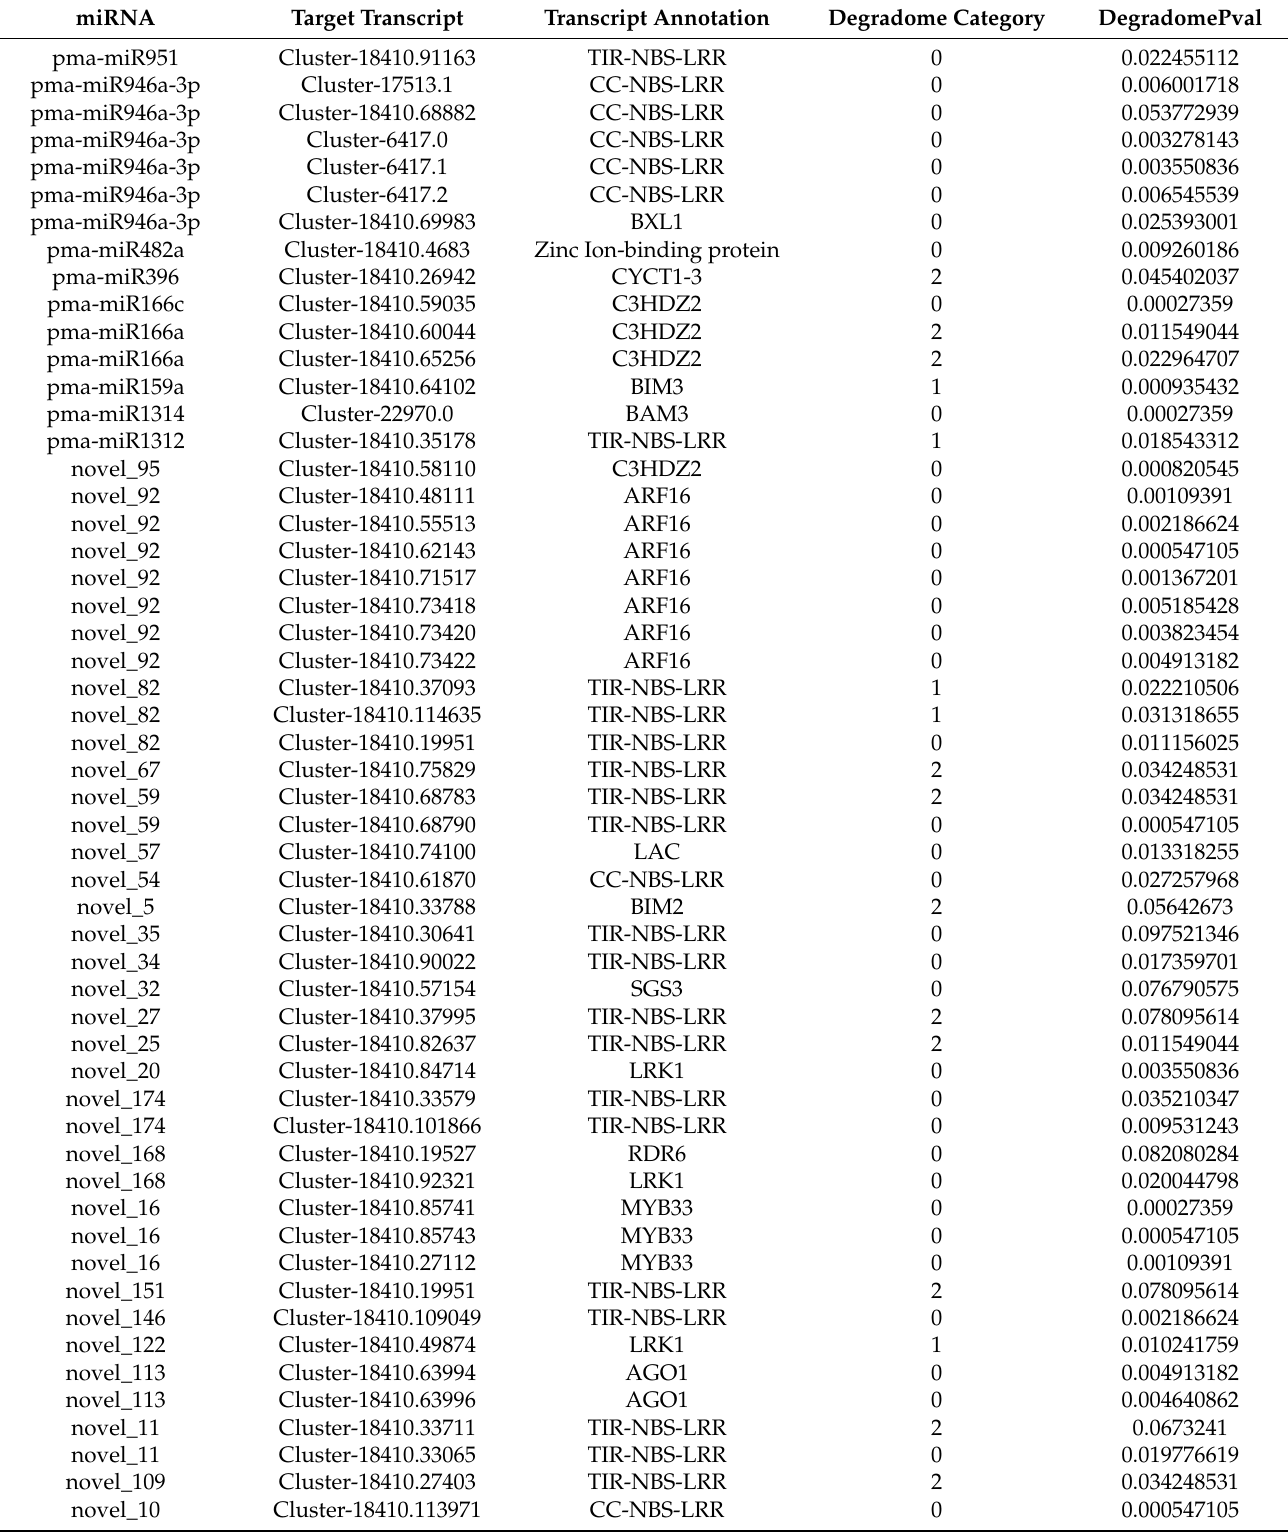
Table 2. Target genes of conserved and novel miRNAs identified in developing xylem of P. massoniana by degradome